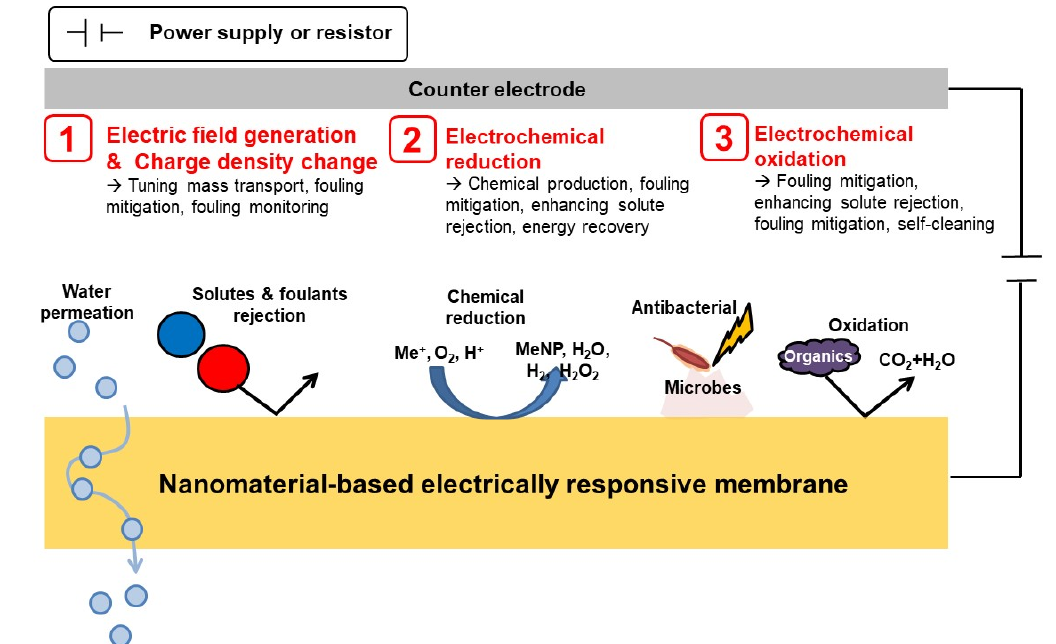
Figure 4. Schematic diagram illustrating the versatile functionalities and working principles of the electrically responsive membranes.